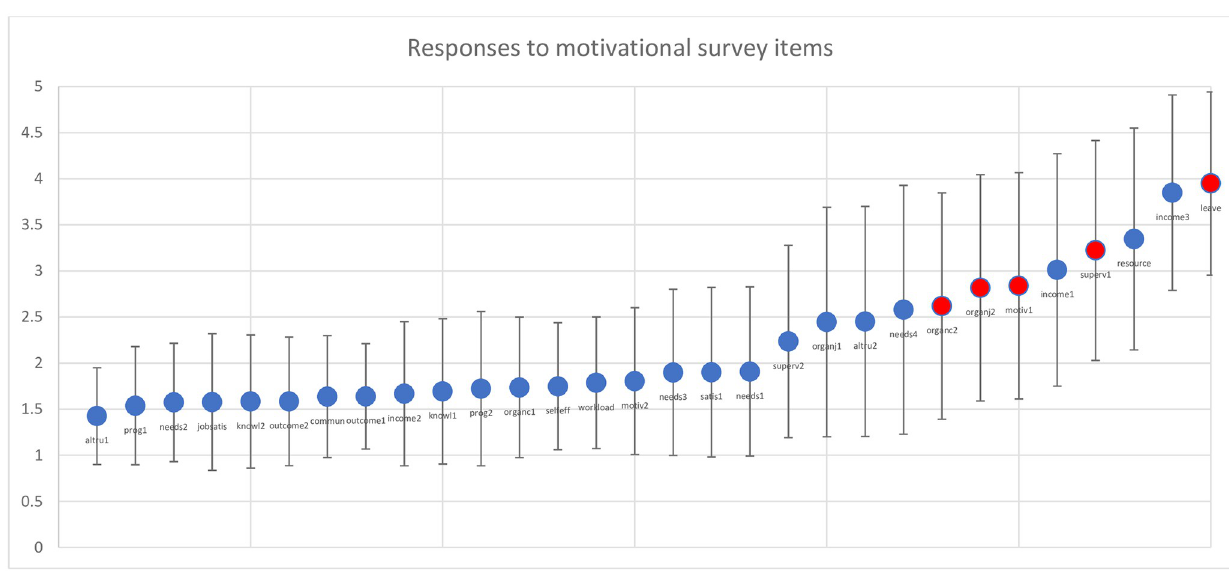
Fig 1. Plot of responses to motivational survey items among participants from four regions of Ethiopia, April 15–May 10,